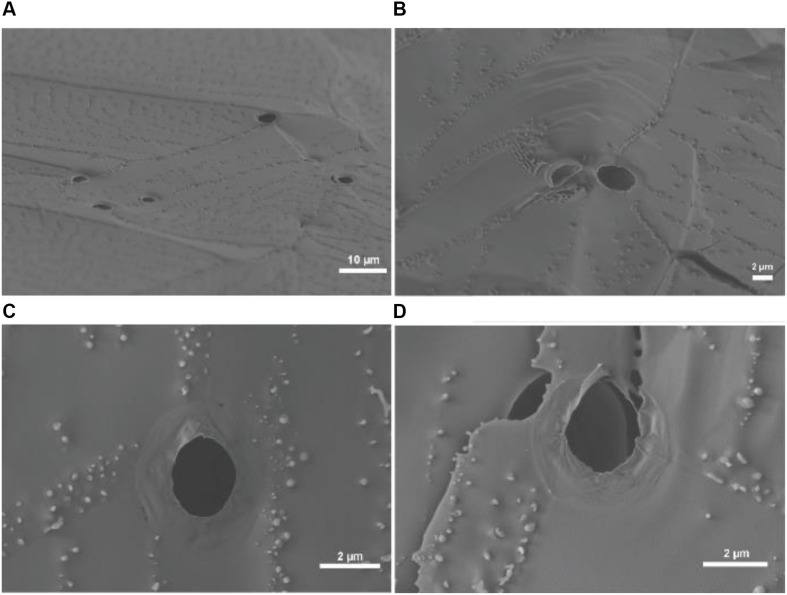
Cryo-SEM images of the self-assembled structures of BZ-PISA for PEG-b-PMEA (DPtarget = 600) sampled at 120 min.